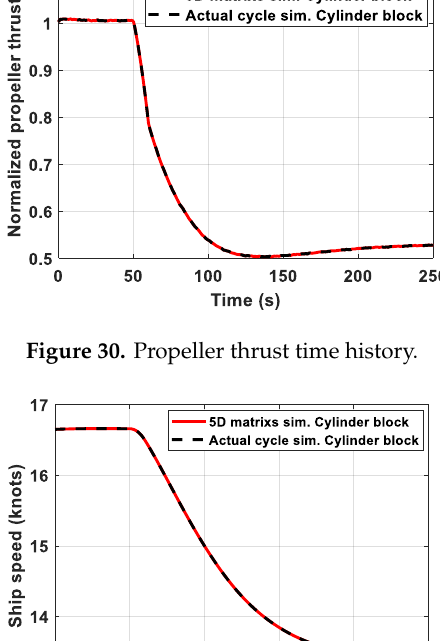
Figure 29. Engine speed time history.